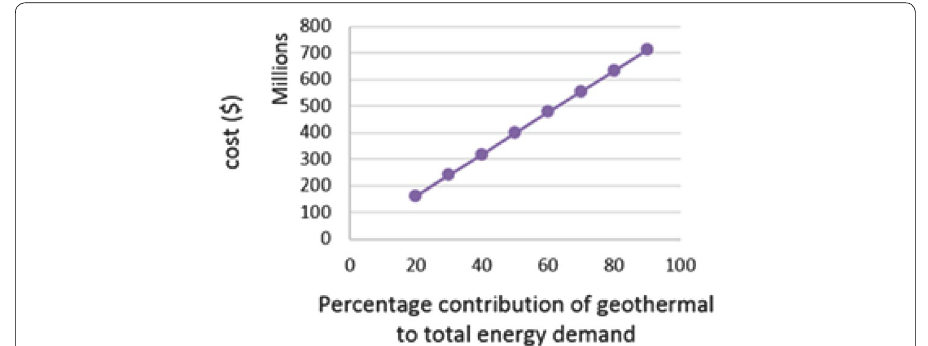
Fig. 15 Cost versus percentage contribution of geothermal energy to the total energy demand